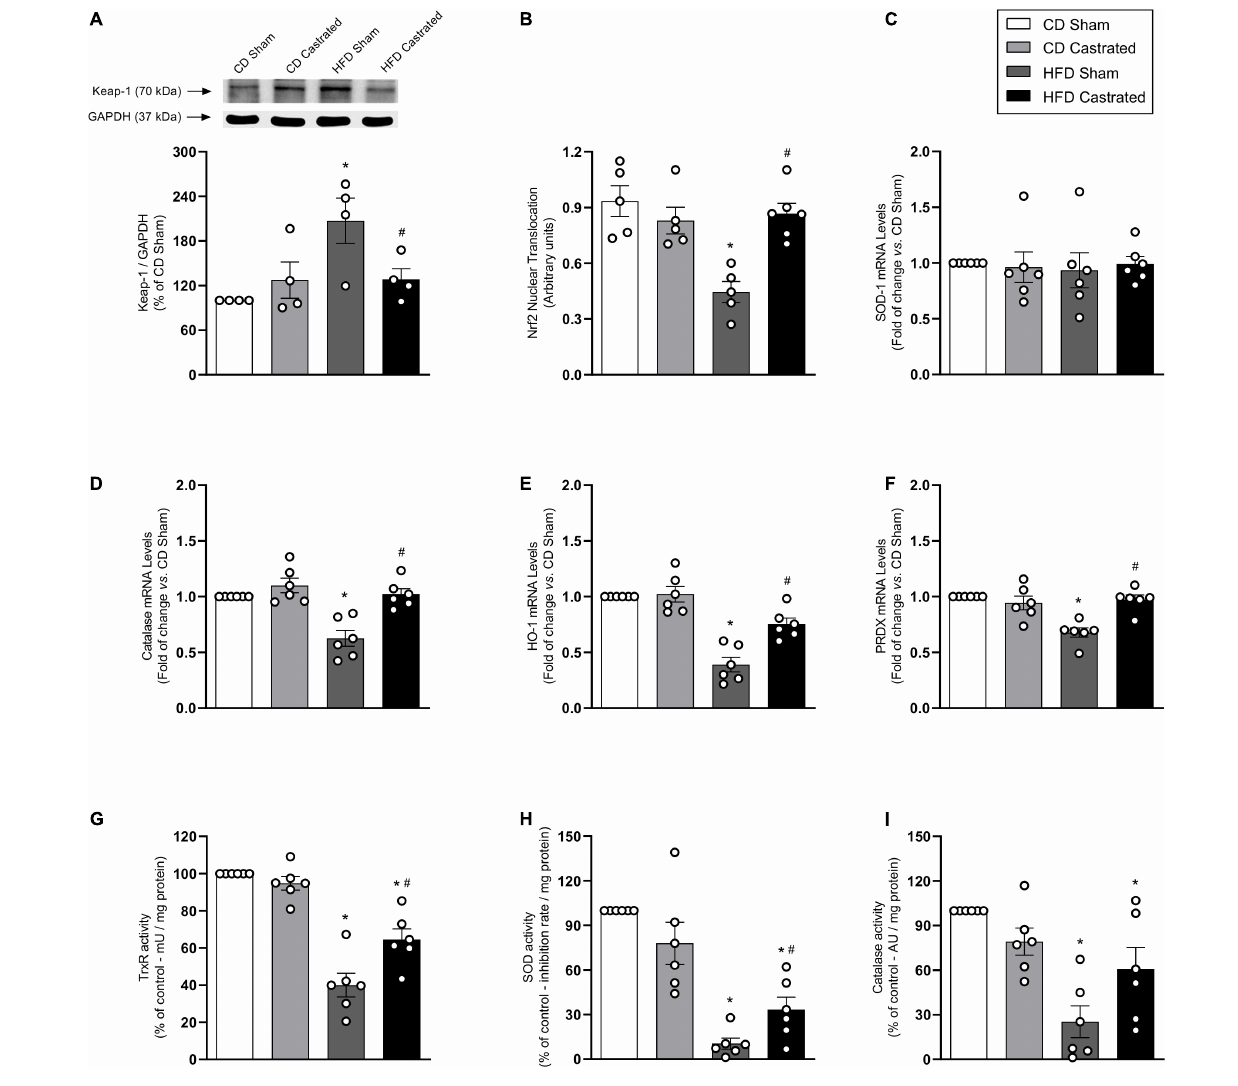
with no additional effects being observed in arteries from castrated mice incubated with bardoxolone. Bardoxolone did not change vascular reactivity in sham or castrated mice fed the CD. Bardoxolone increased nuclear accumulation of Nrf2